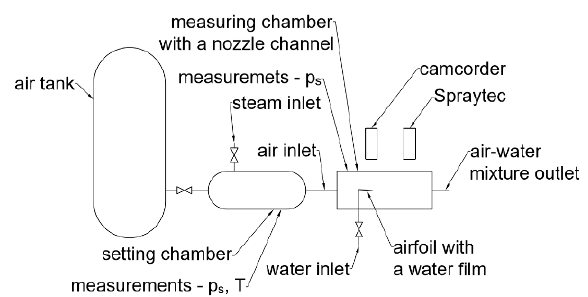
Fig. 2. Measurement schema of the nozzle.